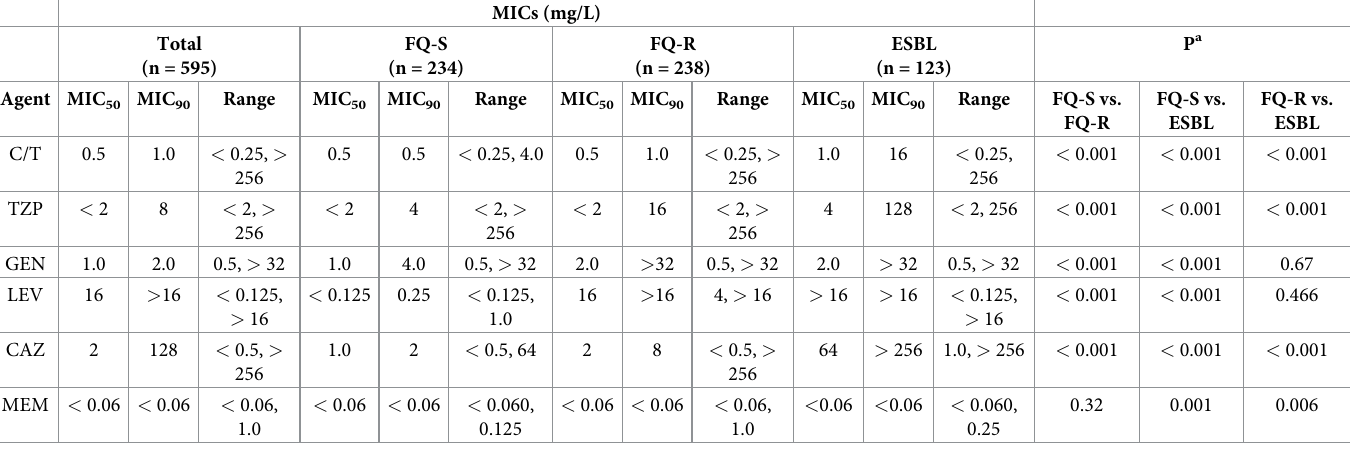
Table 2. MICs for ceftolozane/tazobactam and comparator agents in relation resistance category among 595 Escherichiacoli clinical isolates from